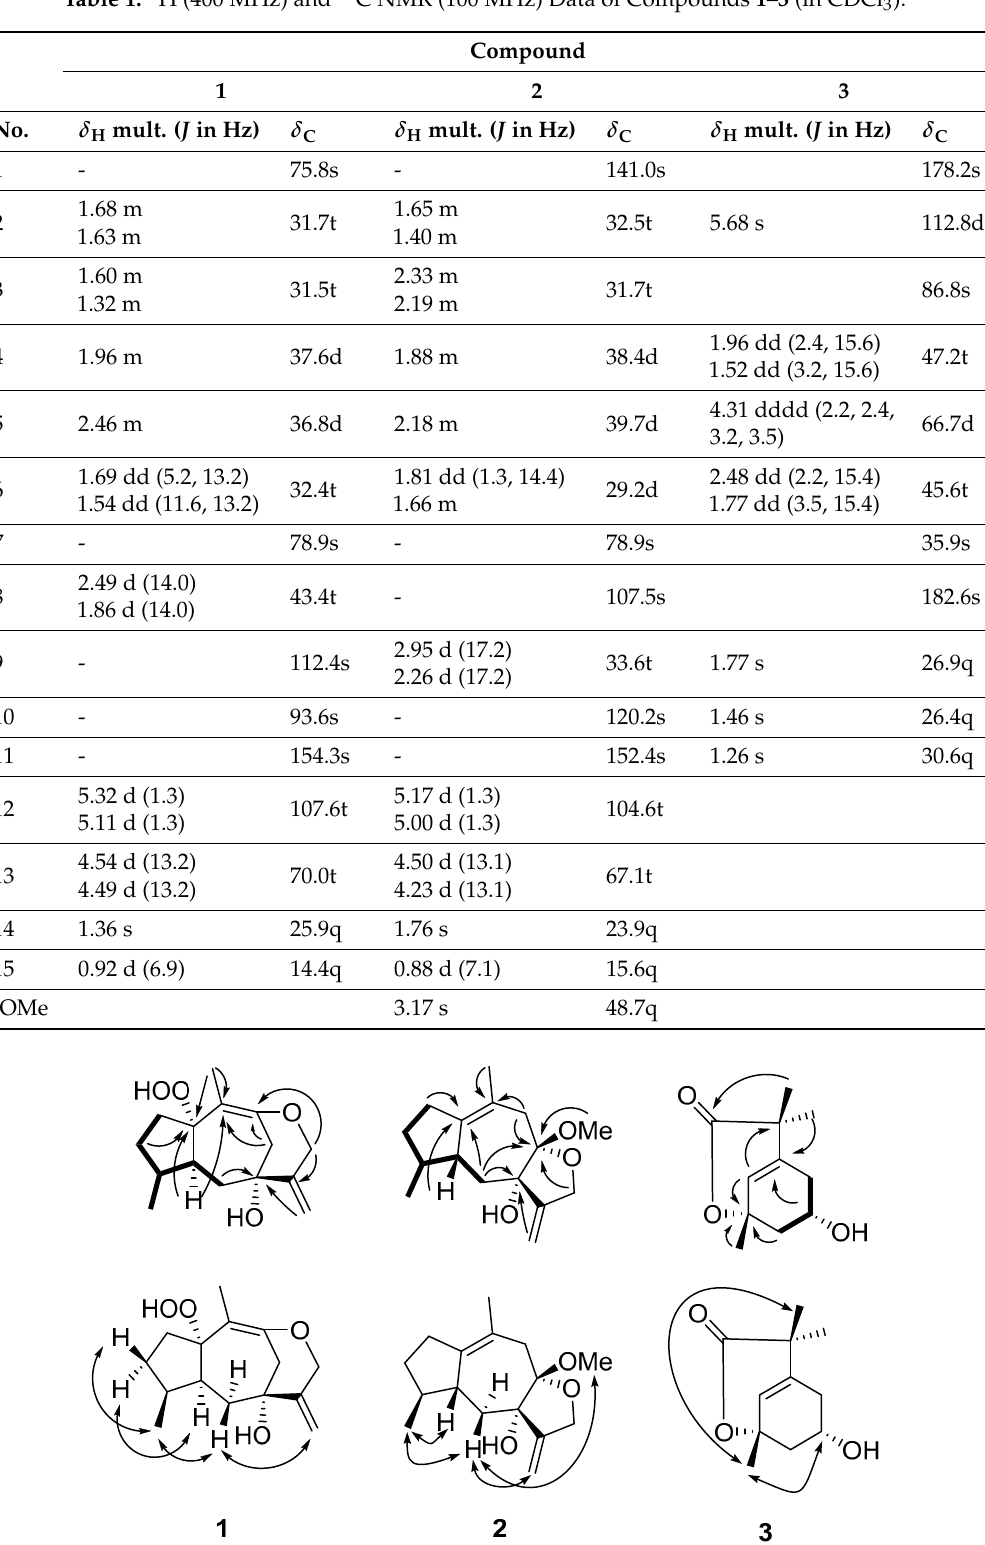
Table 1. 1 H (400 MHz) and 13 C NMR (100 MHz) Data of Compounds 1 – 3 (in CDCl 3 ).